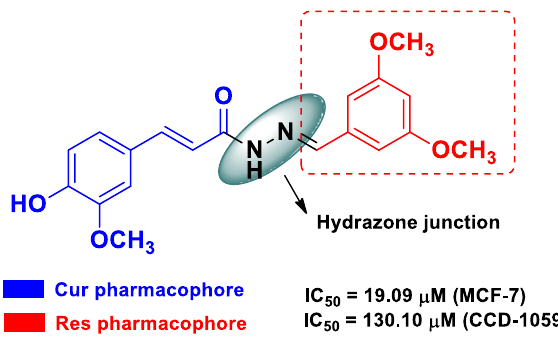
Figure 17. Structure and activity of the most potent Cur – Res hybrid derivative developed by de Freitas Silva et al. [53].